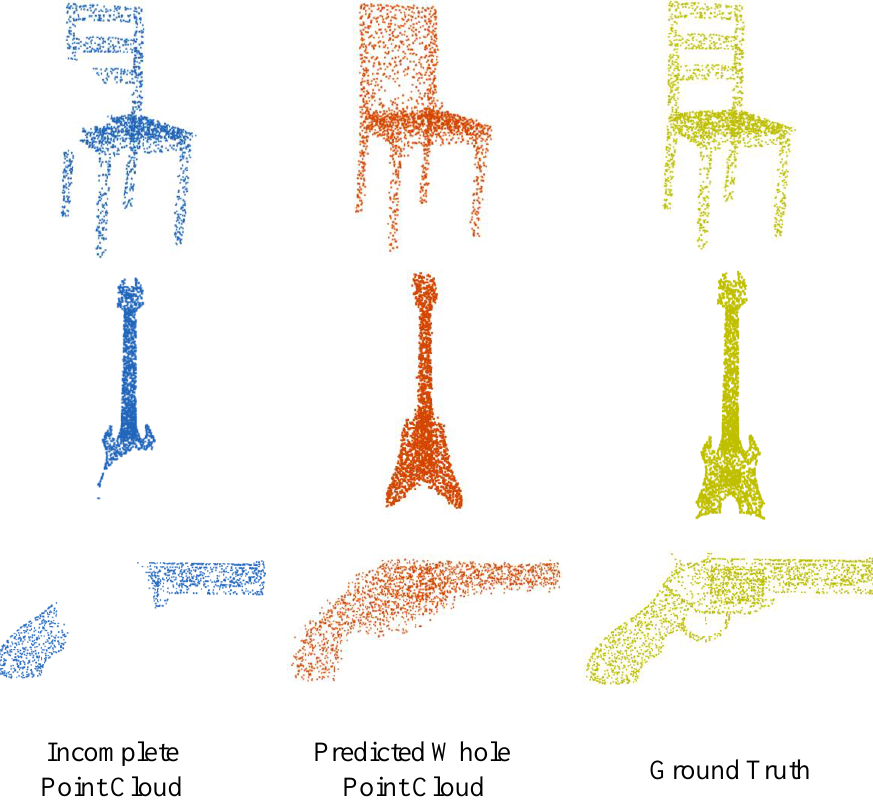
Figure 1. The overall point-cloud structure of the object is outputted directly from the trained neural network. Traditional approach tends to ignore the hollow pattern design on the